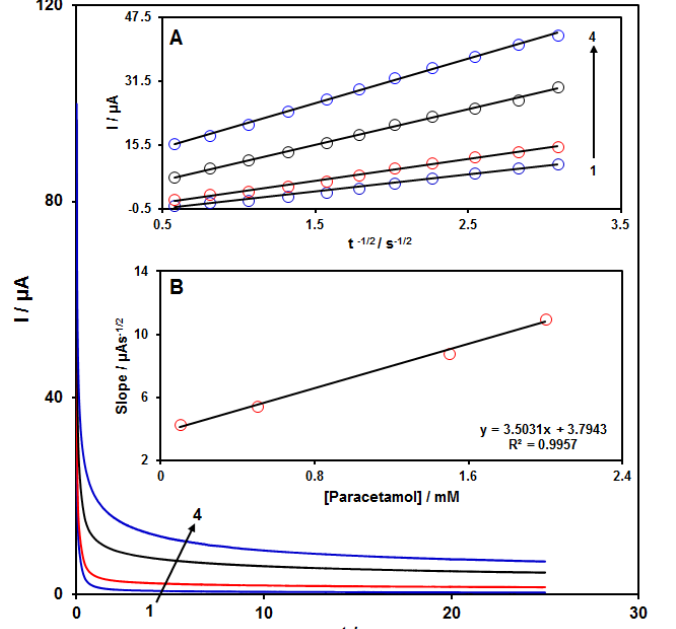
Fig. 7. Chronoamperograms obtained at Cu/SPE in 0.1 M PBS (pH 7.0) for different concentrations of paracetamol. The numbers 1–4 correspond to 0.1, 0.5, 1.5, and 2.0 µM of paracetamol. Insets: (A) Plots of I vs. t -1/2 obtained from chronoamperograms 1–4. (B) Plot of the slope of the straight lines against paracetamol